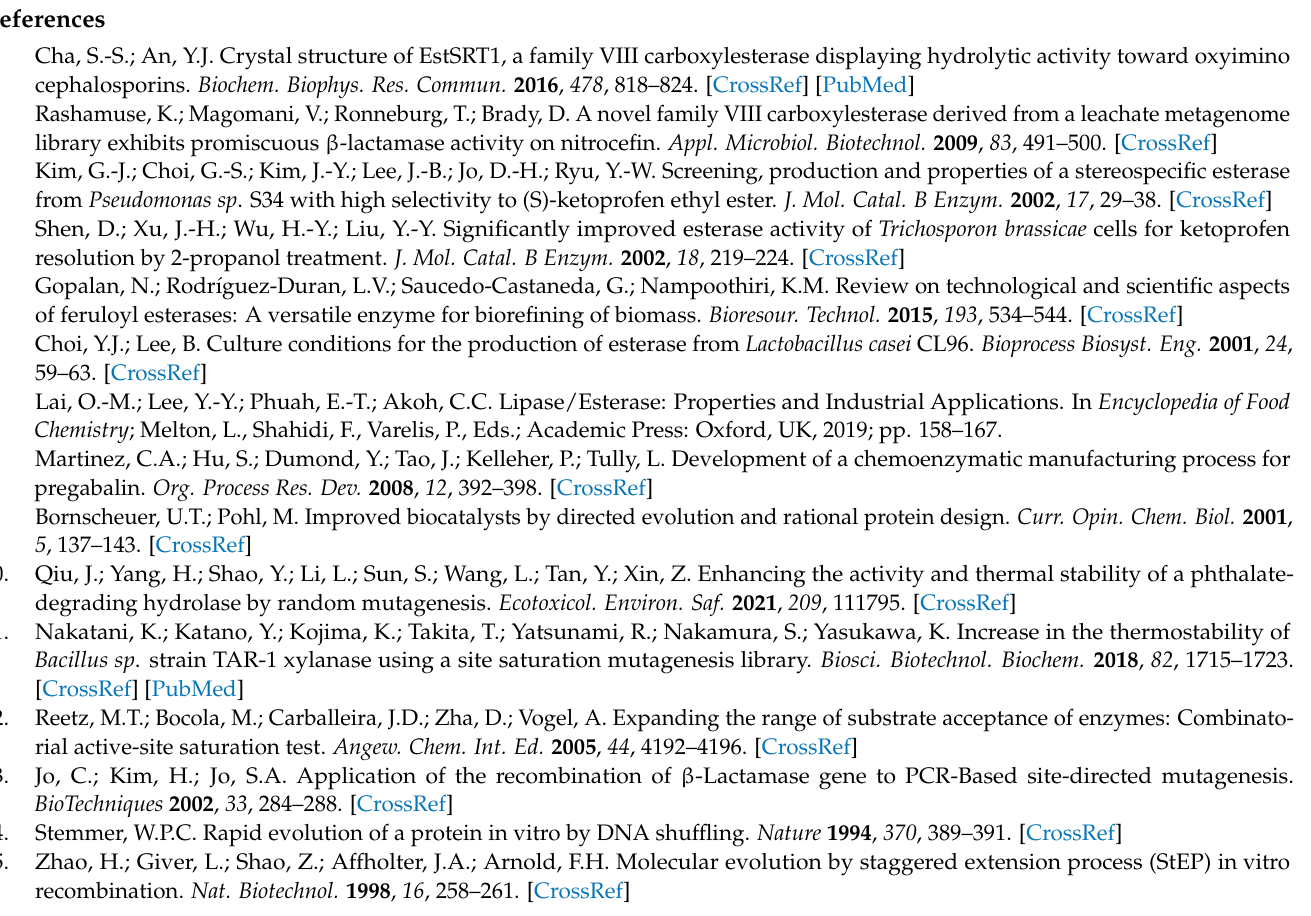
Figure S2: Comparison of relative enzyme activities between WT and mutants; Figure S3: Effects of pH and temperature on the activity of DLFae4 and mutants; Figure S4: Ramachandran plot of DLFae4 and mutants; Figure S5: Hydrophobic pocket graphics of DLFae4 and mutants; Figure S6: DLFae4 catalyzed the formation of insoluble phenethyl acetate; Figure S7: GC-MS analysis of the structure of the product after the reaction of vinyl acetate and 2-phenylethanol; Figure S8: HPLC analysis of the product after the reaction of vinyl acetate and cyanidin-3-O-glucoside; Table S1: Mutatable sites predicted by HotSpot wizard for hydrolytic activity of